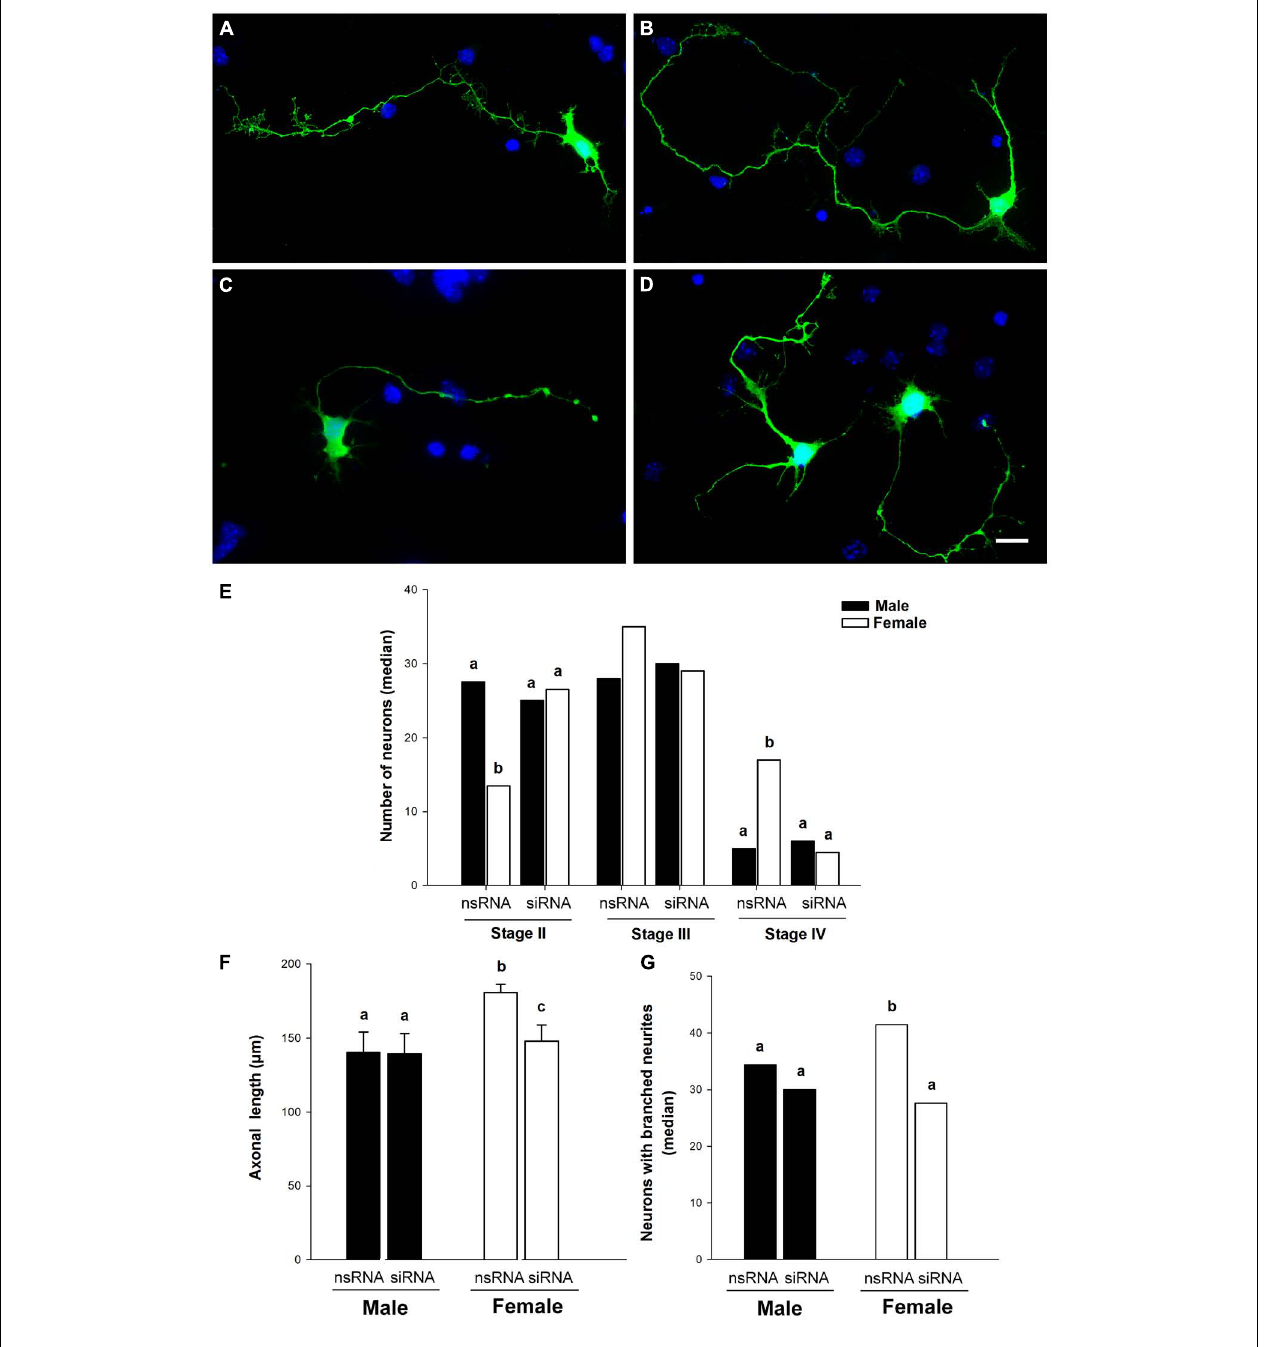
FIGURE 5 | Down-regulation of Ngn3 expression abolished sex differences in maturation and neuritic growth of hypothalamic neurons. Neurons were co-transfected with the Ngn3 siRNAs and pEGFP-C2 at 3 DIV and processed for immunostaining 16 h latter. (A,B) Representative example of male (A) and female (B) neurons treated with non-targeting siRNA. (C,D) Representative example of male (C) and female (D) neurons treated with the Ngn3 siRNA. Scale bar, 10 μ m.